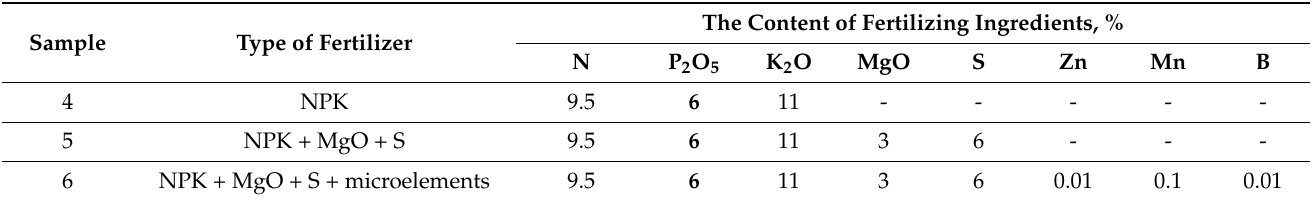
Table 8. Composition of fertilizers of the 1st series with the main composition of NPK: 9.5–6-11.